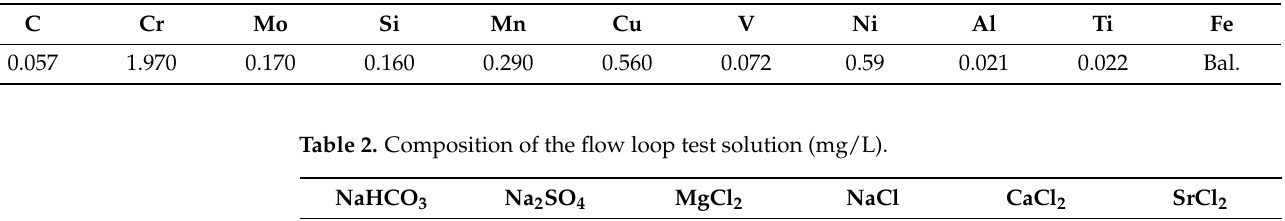
Table 1. Chemical composition of antibacterial alloy steel.